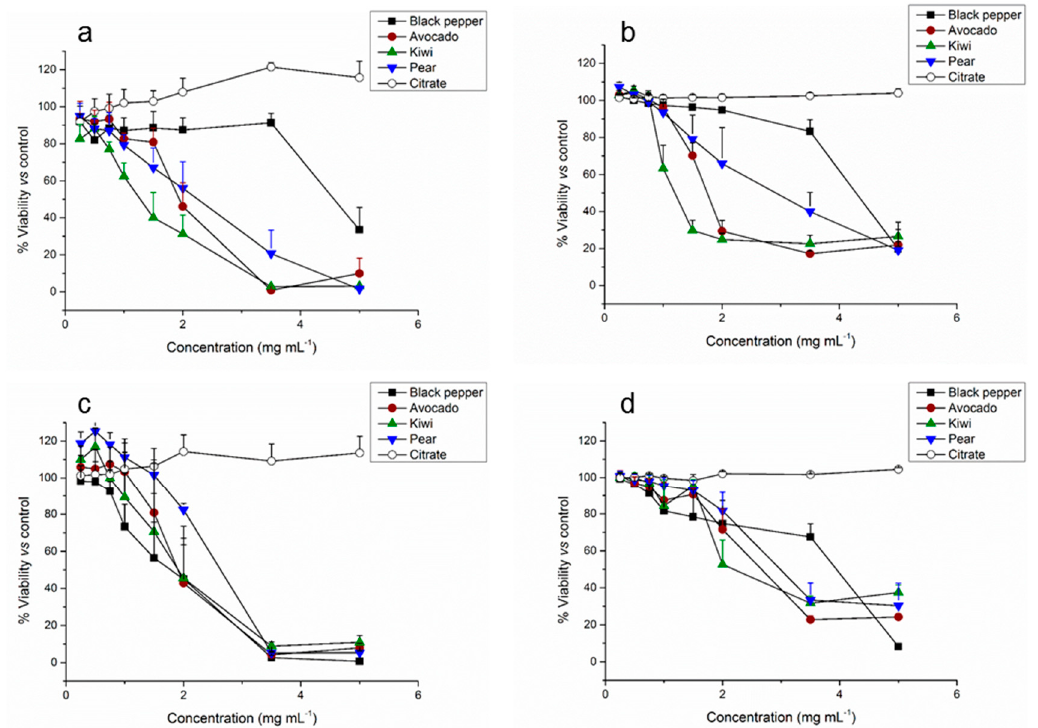
Figure 5. Cell viability evaluation after 48 h ( a , c ) and 72 h ( b , d ) incubation with growing concentrations of each CD. Results are expressed as viability mean ± SEM of four and seven independent experiments for Caco-2 ( c , d ) and HK-2 ( a , b ) respectively. Table 2. Lethal dose i.e., LD 50 of kiwi CD, pear CD, avocado CD, and pepper CD after 72 h exposure to Caco-2 cells and HK-2 cells and after 80 h exposure to zebrafish embryos.